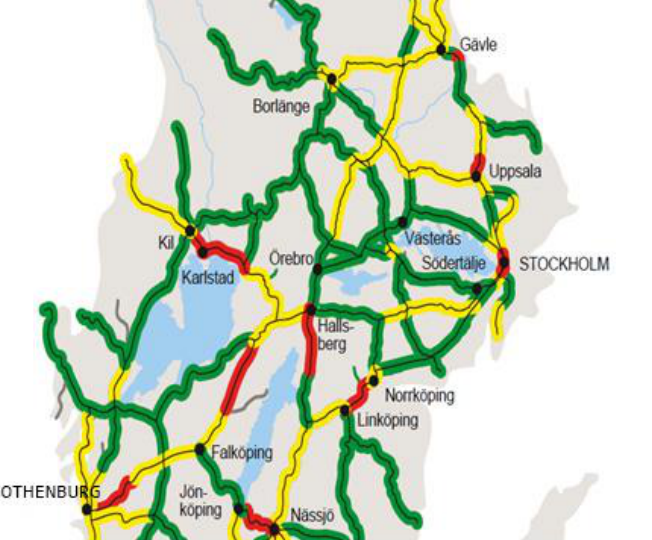
Figure 2: Capacity constraints on Swedish rail network between Stockholm and Gothenburg Source: Trafikverket (2014b) Capacity limitations are shown as green for low, yellow for medium and red for